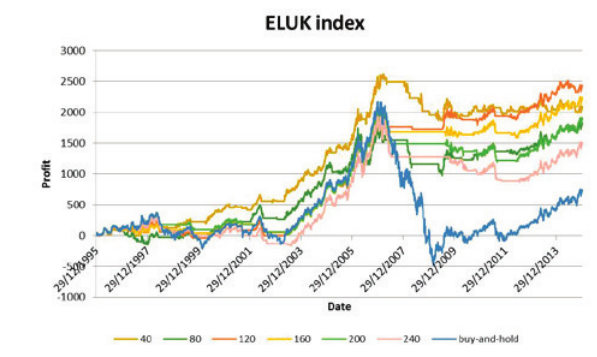
Figure 1. Profits of our strategy and “buy-and-hold” on ELHK index (without transaction costs)